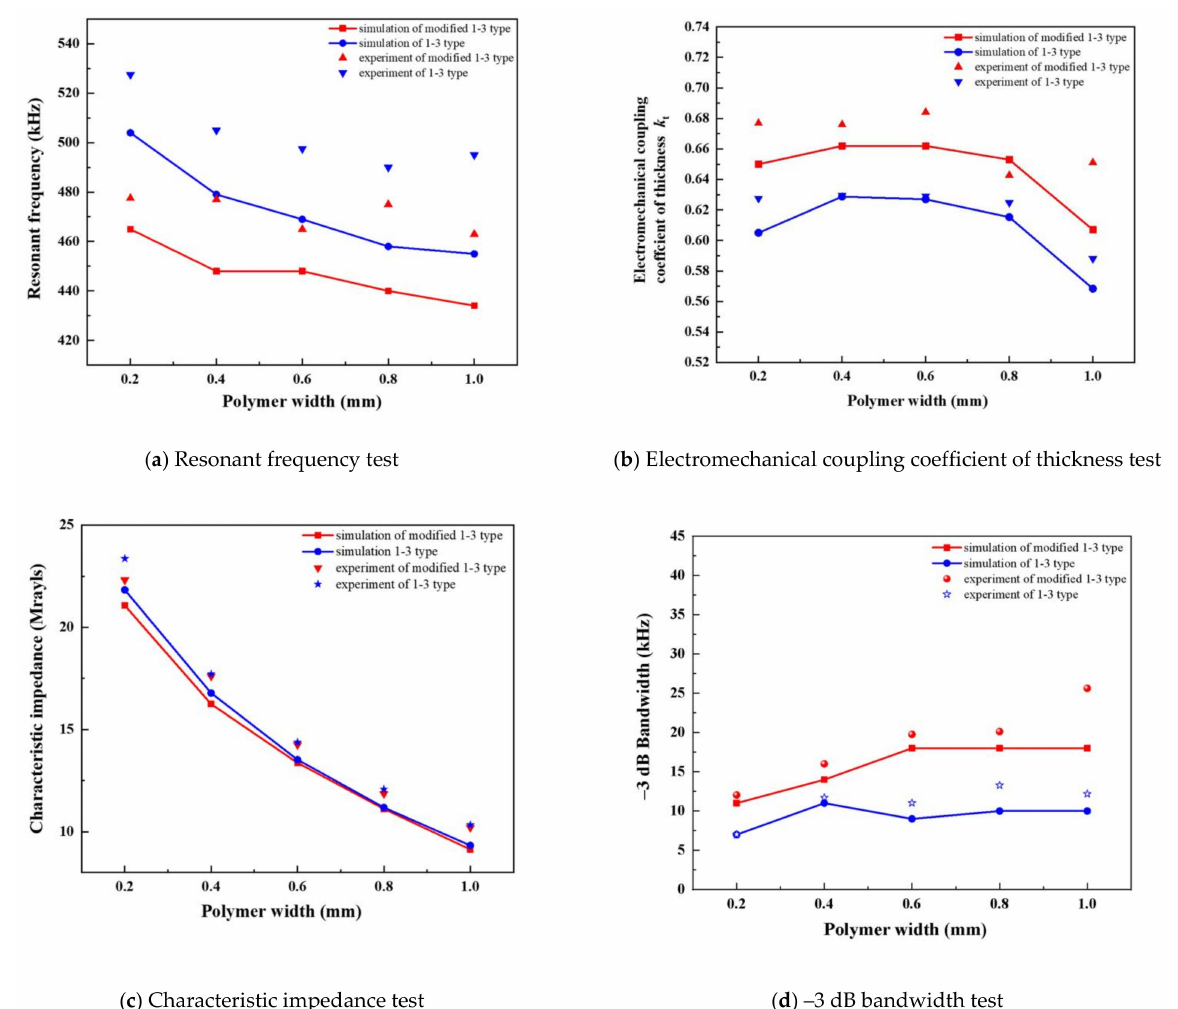
Figure 17. Experimental tests of composites with different polymer widths: ( a ) Resonant frequency test, ( b ) Electromechani- cal coupling coefficient of thickness test, ( c ) Characteristic impedance test, ( d ) − 3 dB bandwidth